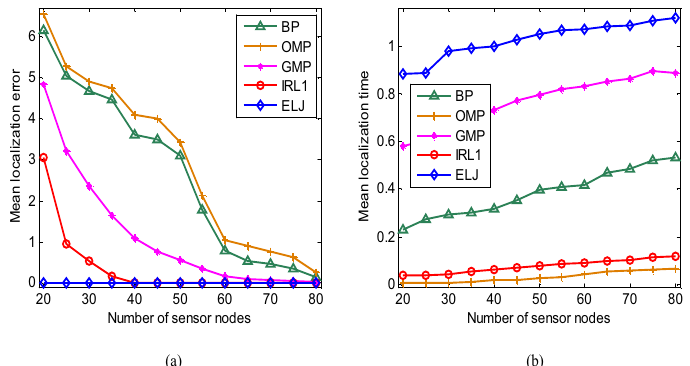
Figure 7. Performance analyses of five recovery algorithms for the different number of sensor nodes when K = 5 and p = 0.5. ( a ) Comparison of the mean localization error of BP, OMP, GMP, IRL1 and ELJ for the different number of sensor nodes. ( b ) Comparison of the mean localization time of BP, OMP, GMP, IRL1 and ELJ for the different number of sensor